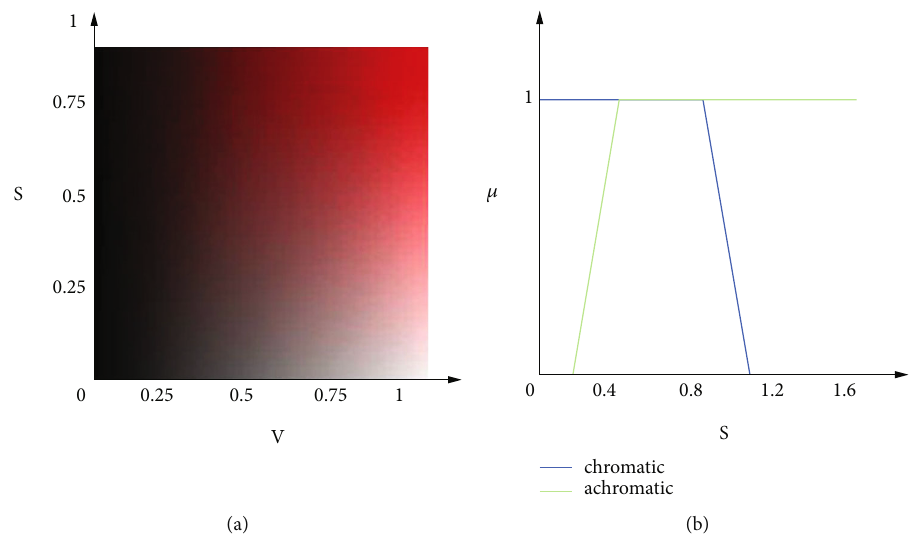
Figure 6: Variation of color with S and V at H = 0 (a) and S -component fuzzy set partition (b).